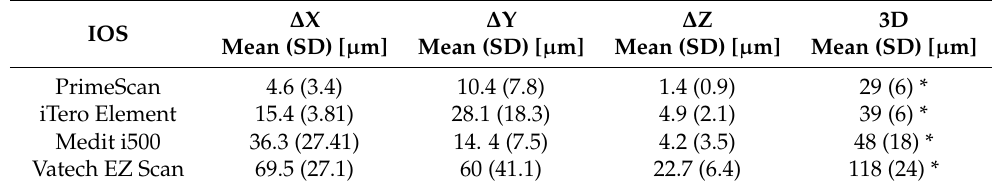
Table 1. 3D position errors of the digital impressions. * difference statically significance ( p -value < 0.05).